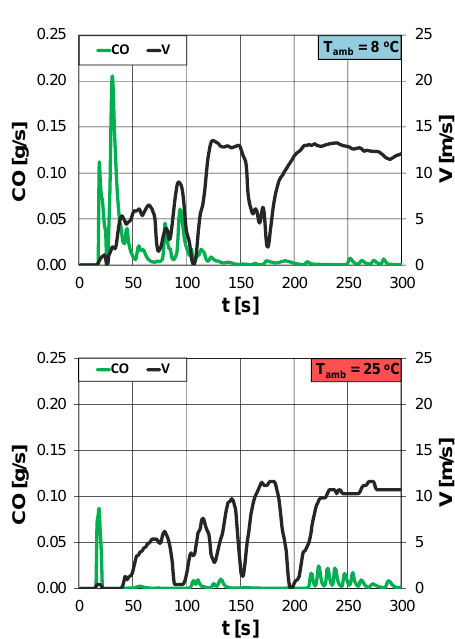
Fig. 6. The exhaust temperature during the cold start phase at different ambient temperatures Fig. 7. Emission intensity of carbon monoxide and vehicle speed during cold start at ambient temperature of 8ºC (a) and 25ºC (b)